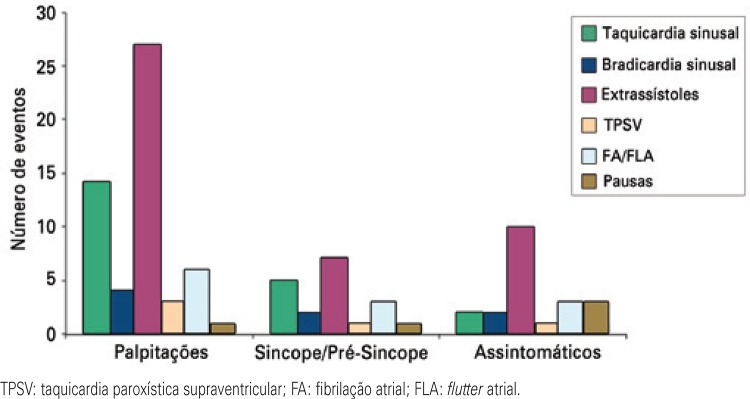
Tipos de ritmo e/ou arritmias encontrados conforme o sintoma específico referido